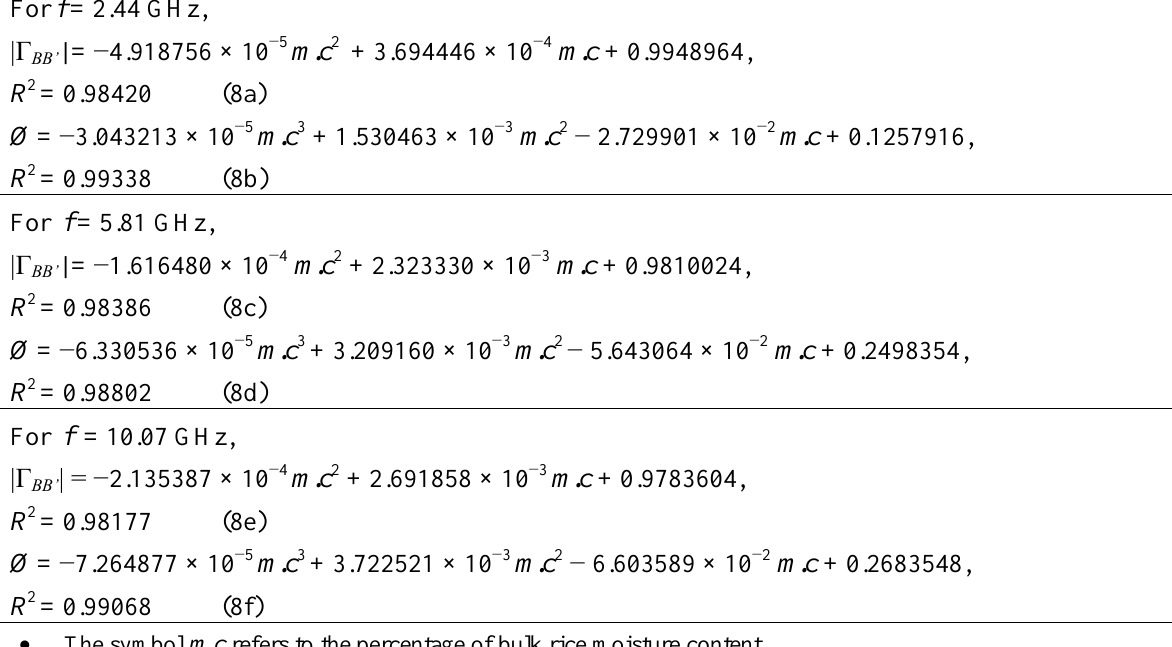
Table 3. Polynomial functions for the reflection coefficient magnitude, |Γ (in rad units) respect to moisture content, m.c. , of the bulk rice (in unit%) For f = 2.44 GHz,